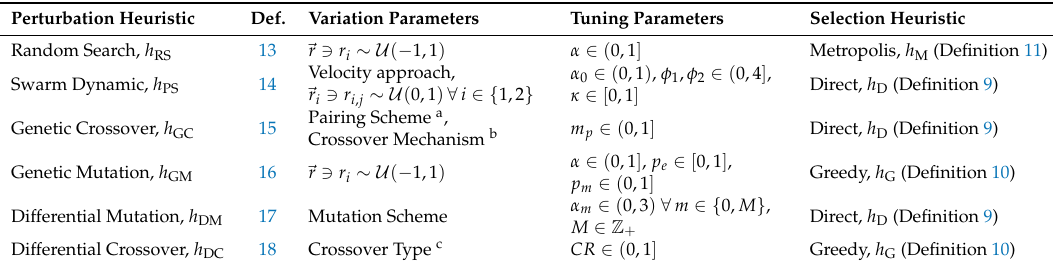
Figure 3. Representation of the selected metaheuristics using the proposed model and their search operators (perturbators and selectors). Table 2. Search operators extracted from four well-known metaheuristics in the literature. Values or ranges for variation and tuning parameters, as well as selectors, are chosen from those commonly employed in the